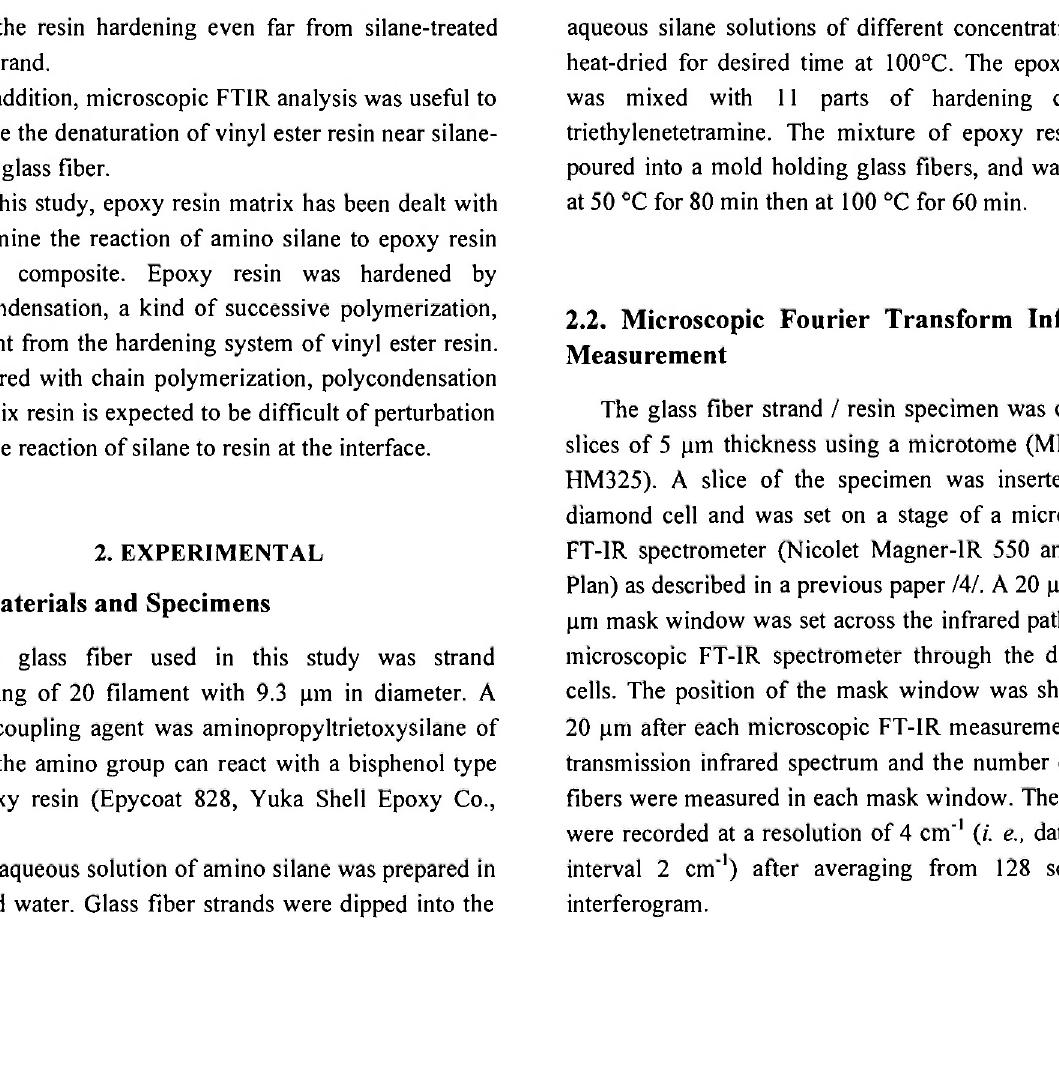
Fig. 1 : Definition of denaturation area in